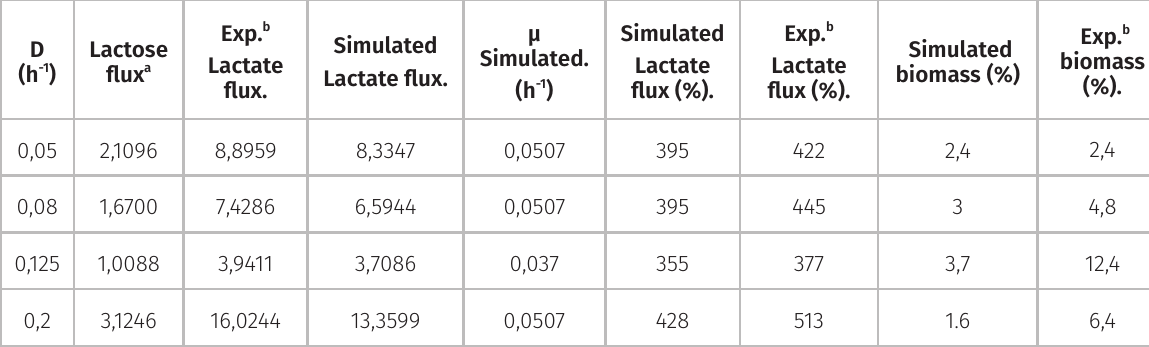
a Flux: mmol g -1 h -1 ; b Exp.: experimental. One mole of lactose produces 4 moles of lactate, for the calculations the positive lactose flux is assumed. % Lactate flux = (lactate flux/lactose flux) *100. % biomass: D or µ / lactose flux *100.